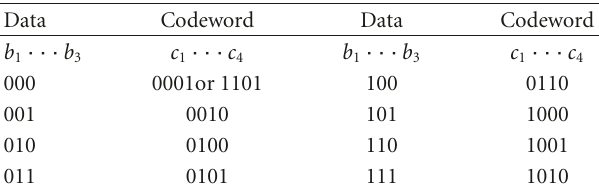
Table 2: Codebook of rate 3 / 4 ( k even 1 = 1, k odd 1 = 2, k = 4)